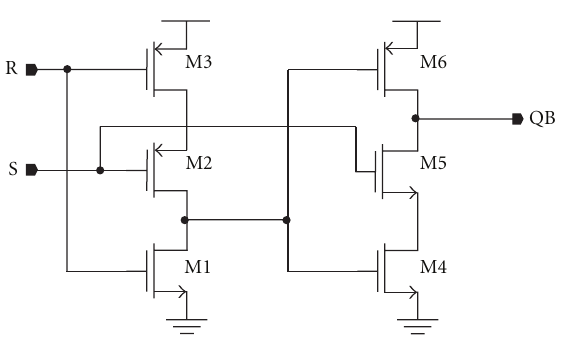
Figure 21: Circuit diagram of